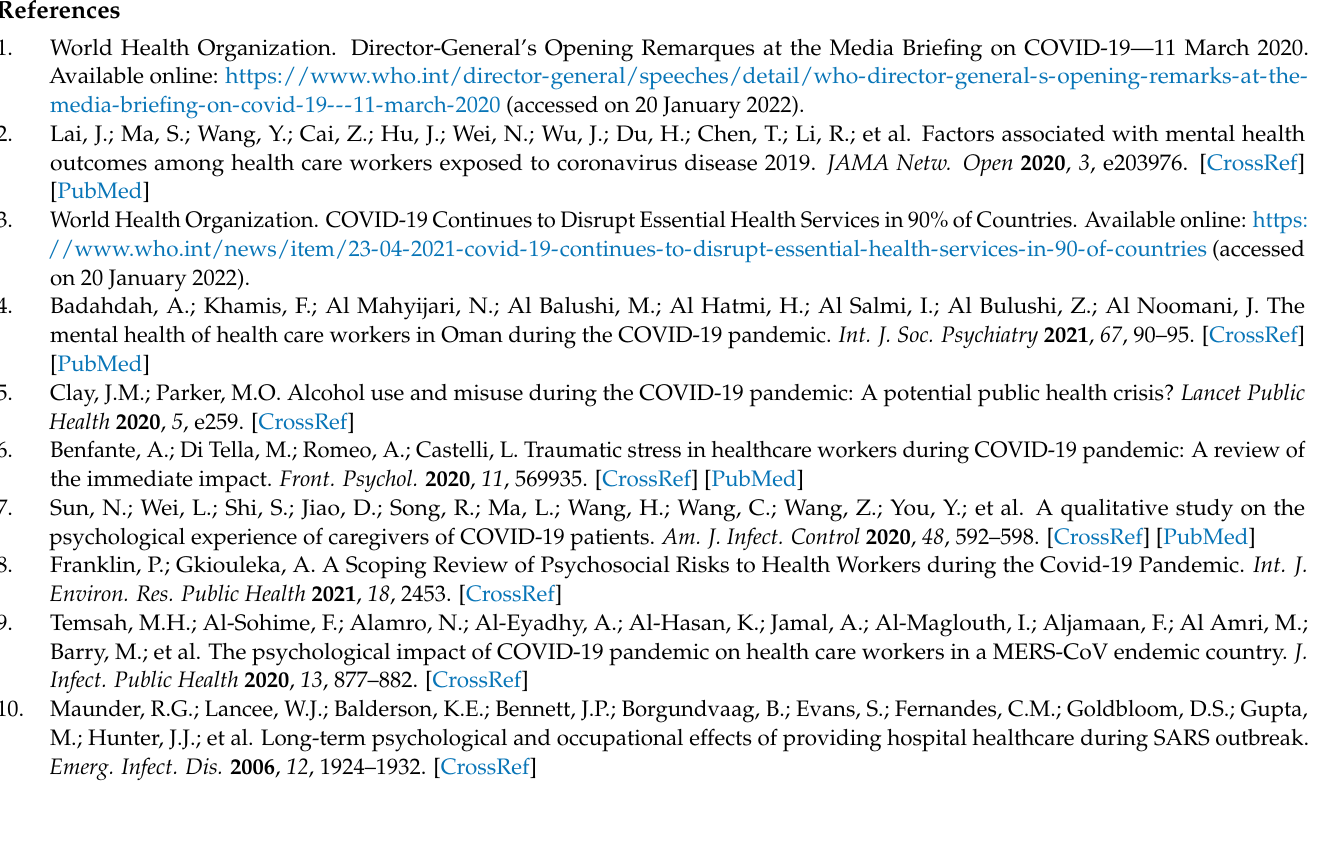
Table S2. Relationship between the negative perspective of the COVID-19 pandemic and selected sociodemographic and cognitive variables in